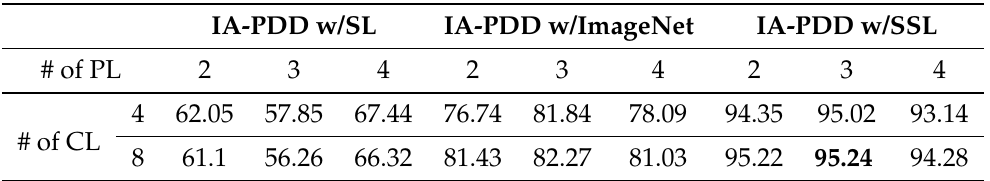
Table 3. Results of ablation study. The ablation study was conducted to visualize performance differences depending on pre-training strategy of feature extractor and number of pooling layers (# of PL) and coupling layers (# of CL). SL, ImageNet, and SSL represent ways to pre-train the feature extractor; these are explained in Section